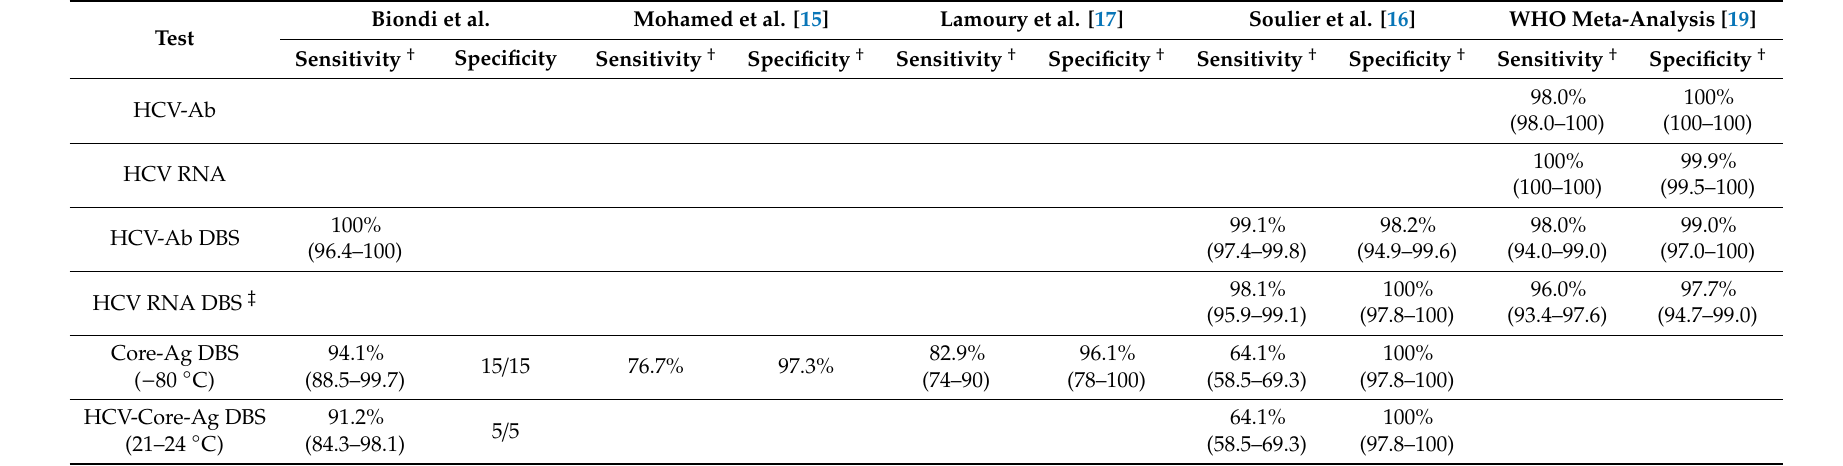
Table 2. Summary of sensitivity and specificity of hepatitis C virus (HCV) diagnostic